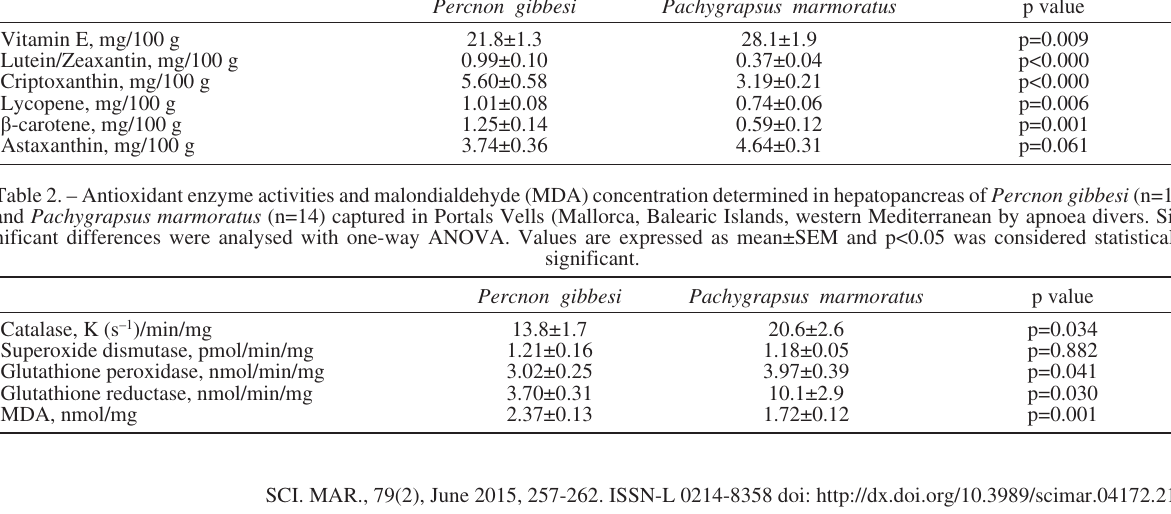
Table 1. – Vitamin E and carotenoid concentrations (mg/100 g) determined in carapaces of Percnon gibbesi (n=14) and Pachygrapsus mar­ moratus (n=14) captured in Portals Vells (Mallorca, Balearic Islands, western Mediterranean by apnoea divers. Significant differences were analysed with one-way ANOVA. Values are expressed as mean±SEM and p<0.05 was considered statistically significant. Percnon gibbesi